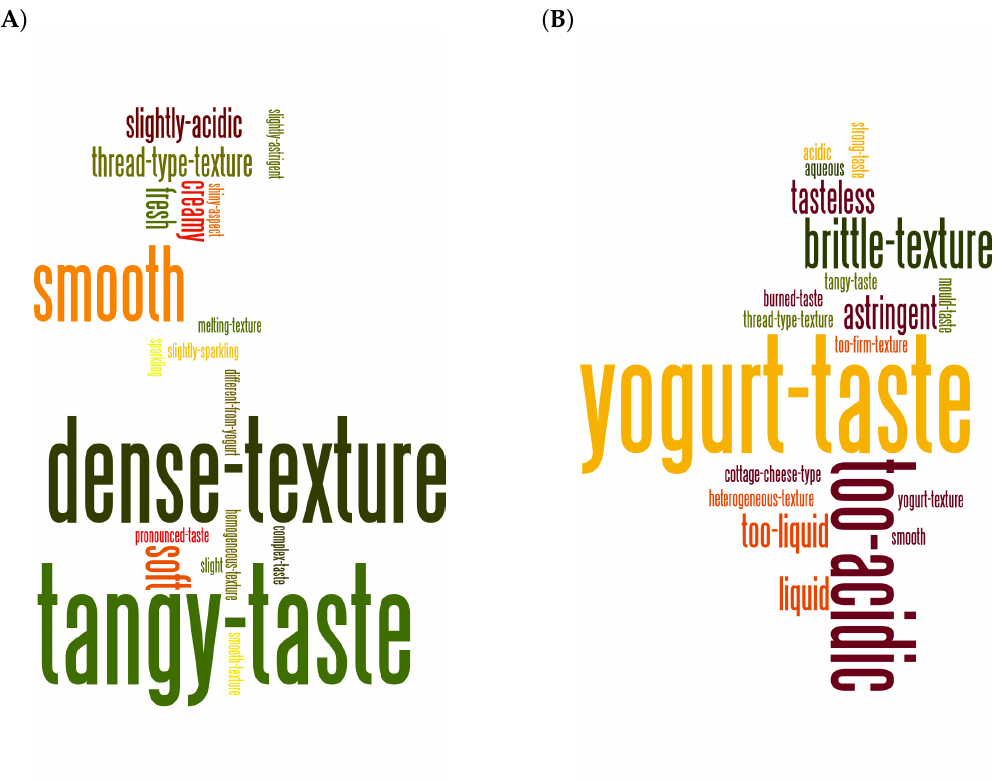
Figure 2. Wordcloud of descriptors used for typical and non-typical Gwell. Word sizes are proportional to the number of citations. ( A ), Gwell considered as typical by panelists; ( B ), Gwell considered as non-typical by